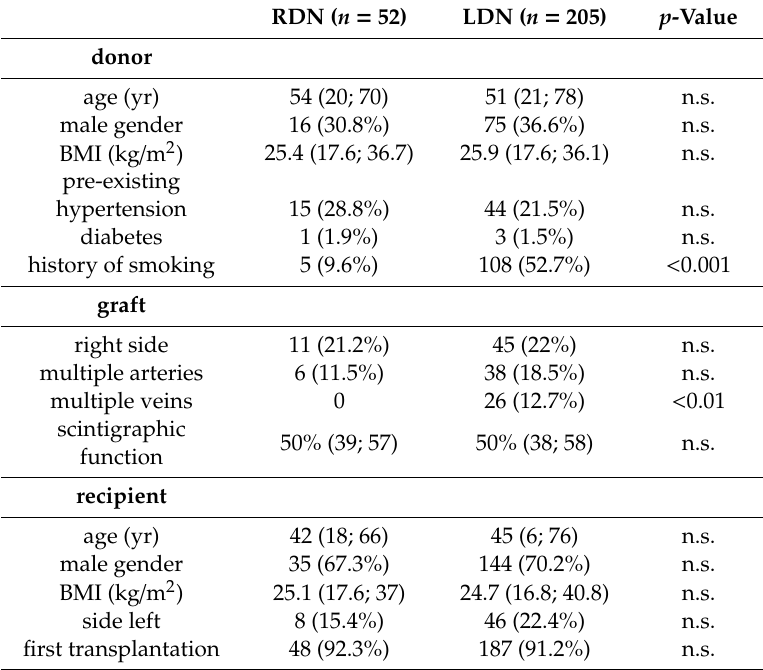
Table 1. Comparison of donor, graft, and recipient